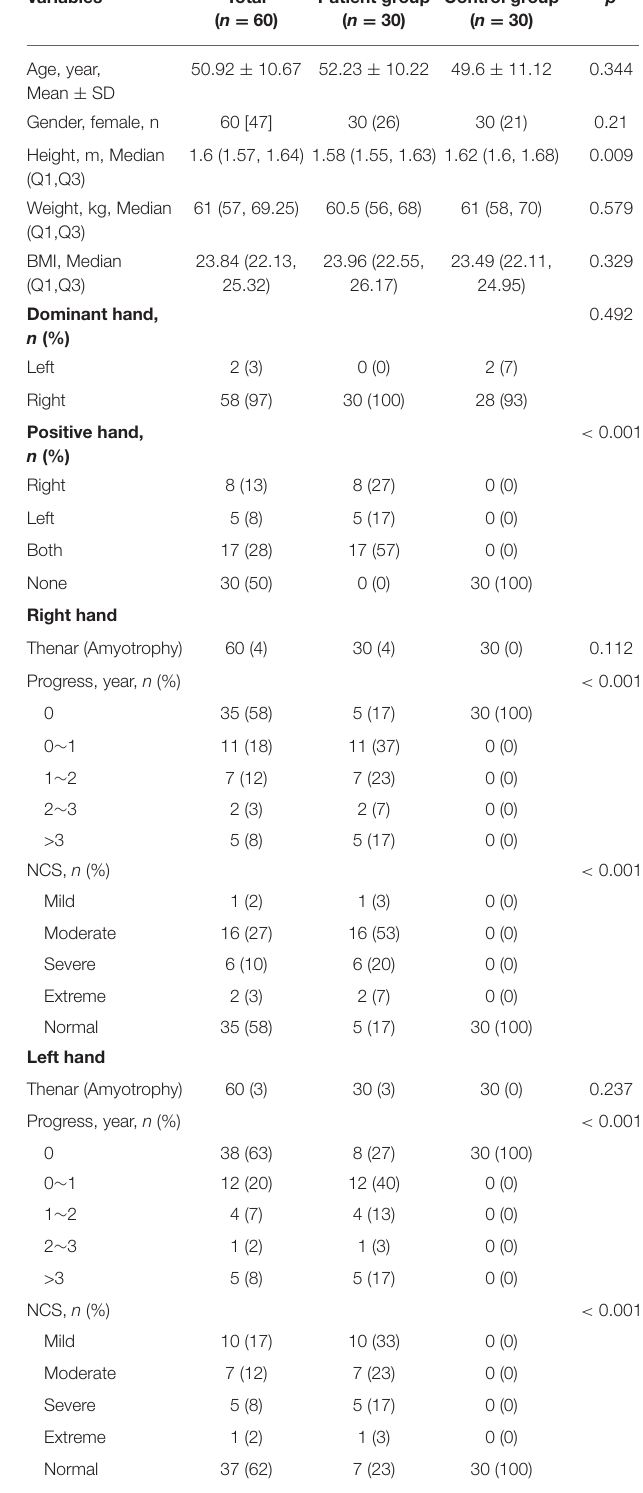
TABLE 1 | Baseline characteristics of the study